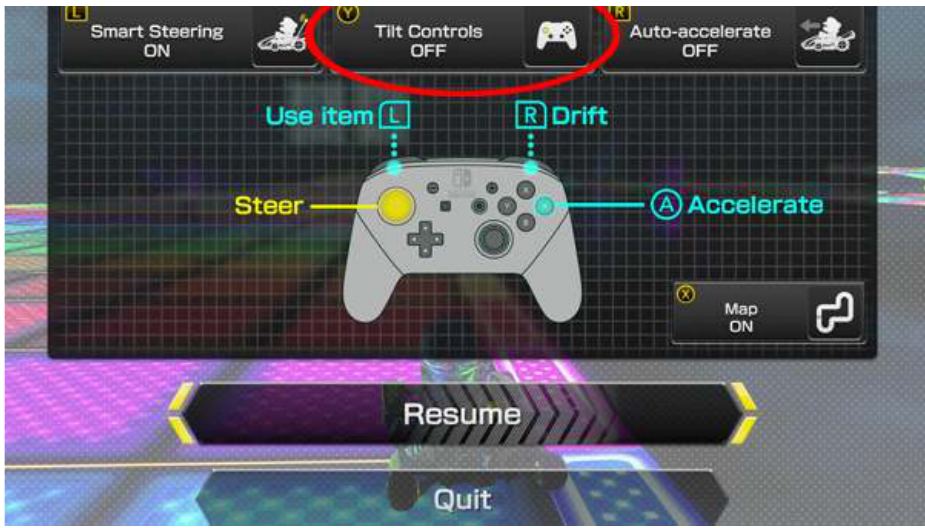
Credits: Mario Kart . Nintendo.